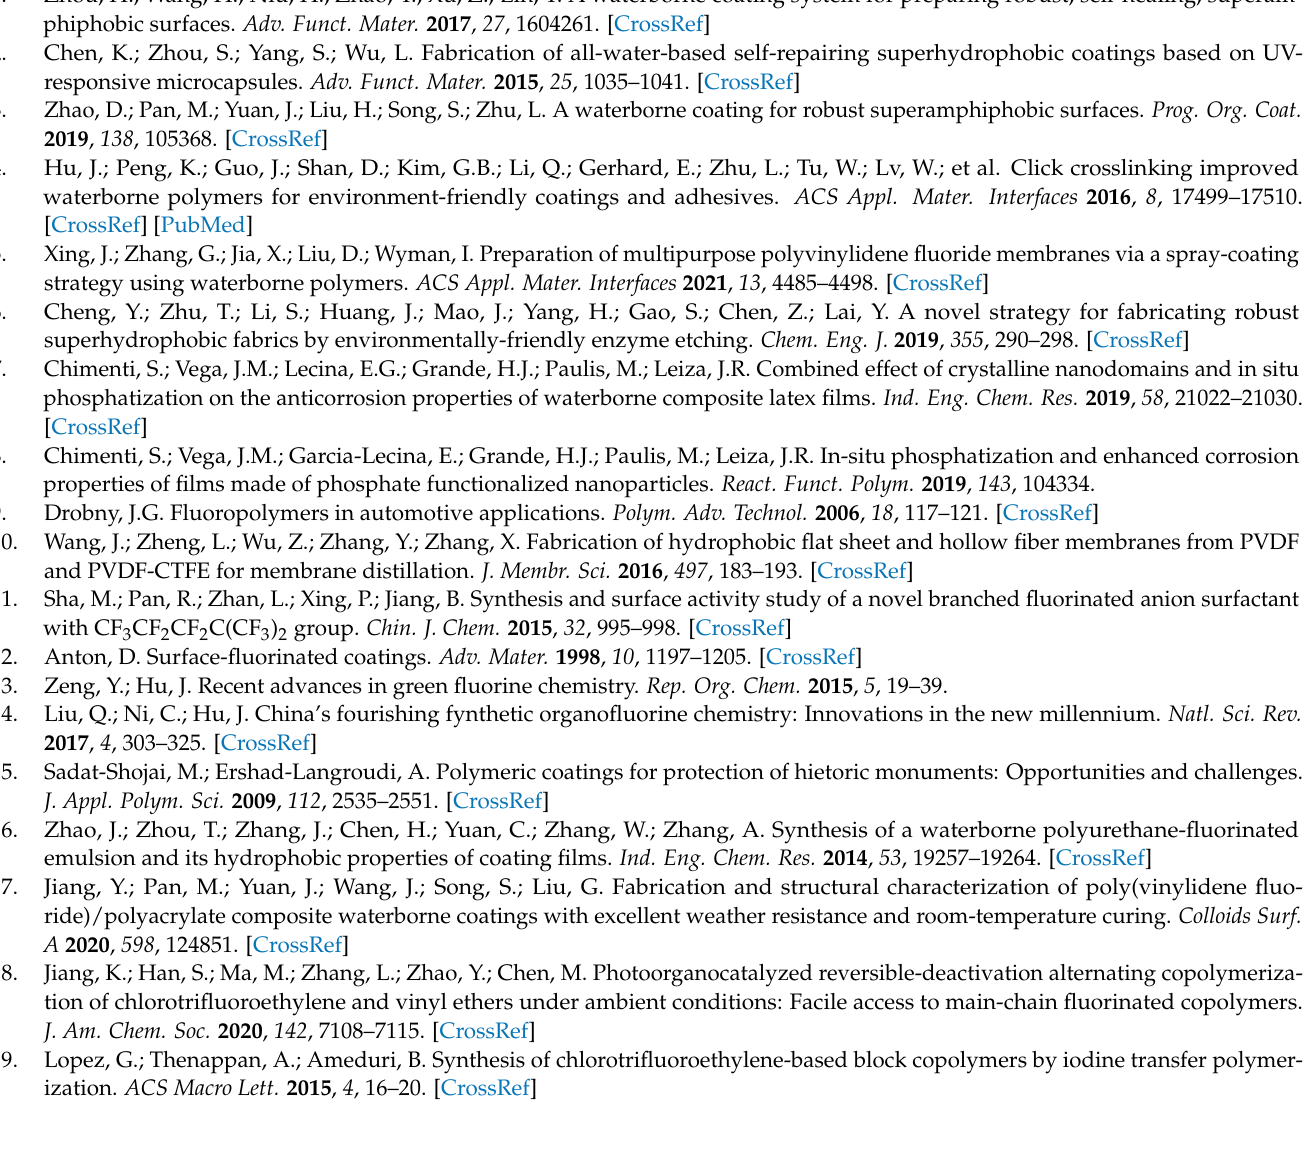
Figure S2: Adhesion performance determination of the P(CTFE- co -IBVE) coating by cross-cut test: (A) glass- based coating before 3M tape application; (B) glass-based coating after 3M tape